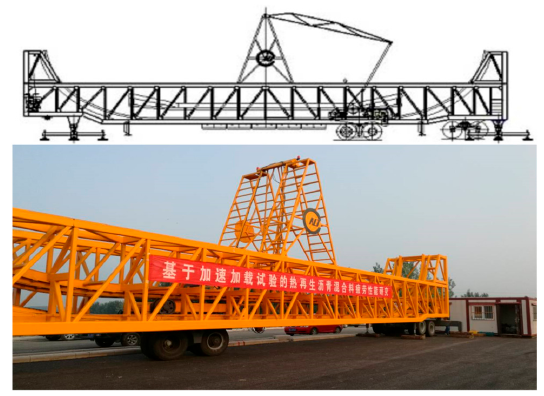
Figure 1. Mobile accelerated pavement loading equipment.